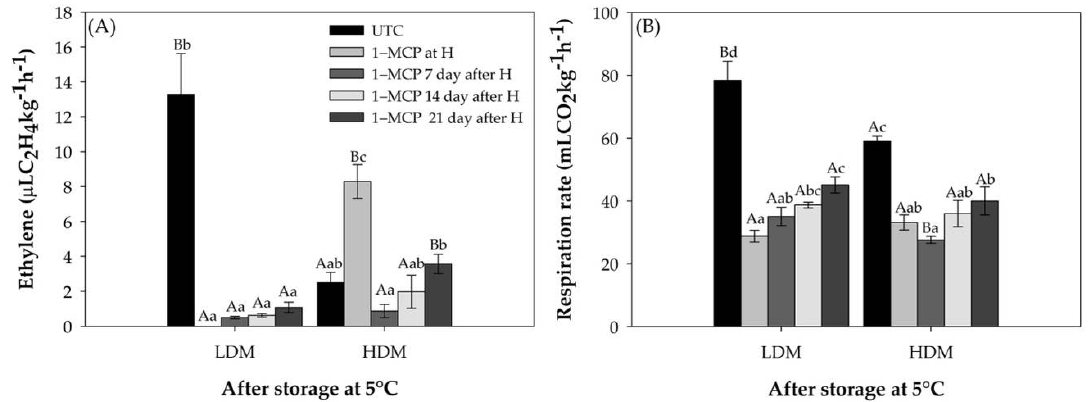
Figure 2. Ethylene production and respiration rate of “Hass” avocado. Untreated control (UTC, fruit without 1–MCP), application of 1–MCP at harvest, 7 d, 14 d, and >21 d after harvest, all fruit were put in cold storage (35 d at 5 °C) in regular air. ( A ) Ethylene production ( L C 2 H 4 kg -1 h -1 ). ( B ) Respi- ration rate (mL CO 2 kg −1 h −1 ). Different lowercase and capital letters indicate a significant difference among treatments and maturity stages by LSD analysis ( p < 0.05). H: Harvest.